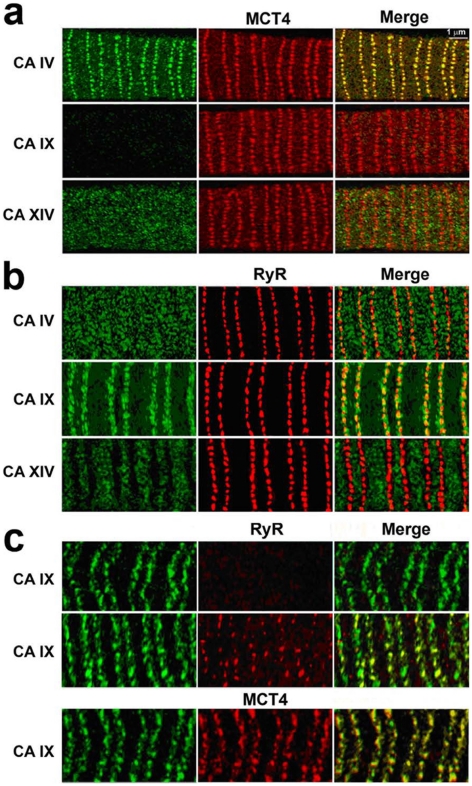
Immunocytochemical CLSM images from fibers of mouse EDL muscle.a) Simultaneous exposure to antibodies against CA IV, CA IX or CA XIV and MCT4. The microscope was focussed on the plane of the fiber surface membrane. CA IV, basal homogeneous membrane staining and enrichment at entrances to T tubuli. CA IX, absence from the surface membrane. CA XIV, homogeneous surface membrane staining. b) Simultaneous staining with antibodies against CA IV, CA IX or CA XIV and RyR. The microscope was focussed on a plane inside the cell exhibiting triads. CA IV, staining of entire SR. CA IX, staining of triads (T tubules) but not SR. CA XIV, staining of light SR but not the triads (terminal cisternae of the SR and T tubules). c) Simultaneous staining with antibody against CA IX and RyR or MCT4. In the upper lane, the microscope was focussed on a plane inside the fiber free of triads; nevertheless, CA IX staining exihibits the same staining pattern as in Fig. 1b, middle lane, indicating it is associated with T tubules. In the middle lane a plane is shown, in which RyR are fully, or partially or not at all visible, causing an incomplete RyR pattern compared to that seen in Fig. 1b. Nevertheless, the staining pattern of CAIX is as complete and regular as in the lane above. This confirms that CAIX staining is associated with T tubules but not necessarily with RyR. In the lowest lane it is seen that CA IX and MCT4 are perfectly colocalized in T tubules.